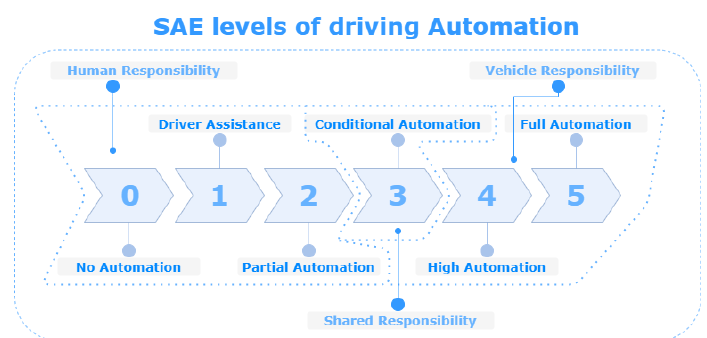
Figure 1. SAE levels of Driving